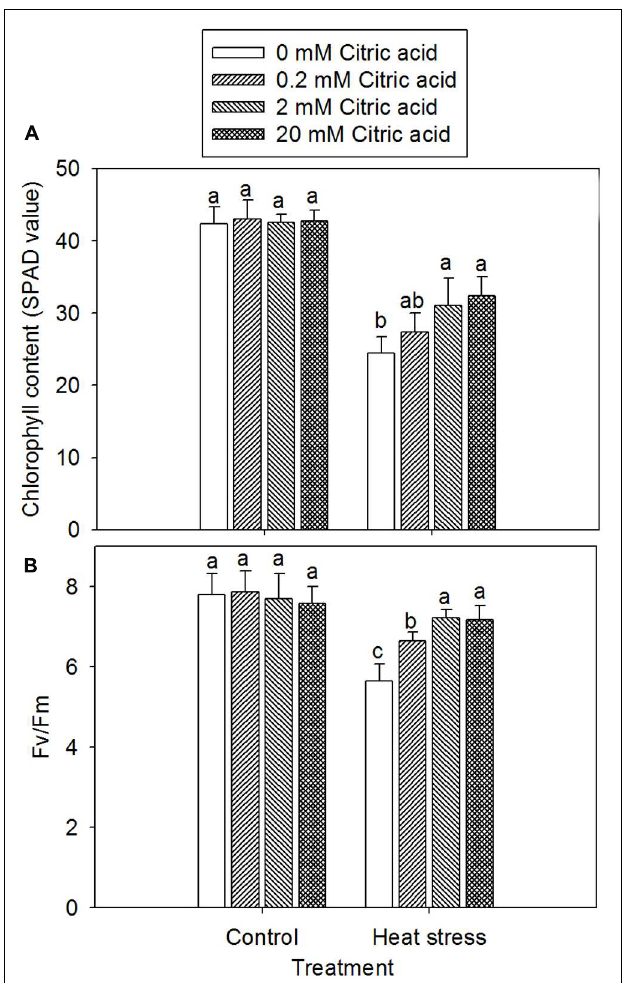
FIGURE 4 | Effect of exogenous citric acid on chlorophyll content (SPAD values; A) and ( F v/ F m; B) under control (25/20 ± 0.5 ◦ C, day/night) and heat stressed (35/30 ± 0.5 ◦ C, day/night) conditions in tall fescue. Vertical bars on the top provide the standard deviation ( n = 4), and bars with the same letter indicate no significant difference at P < 0.05 for the comparison of different citric acid concentrations under control or heat stress.